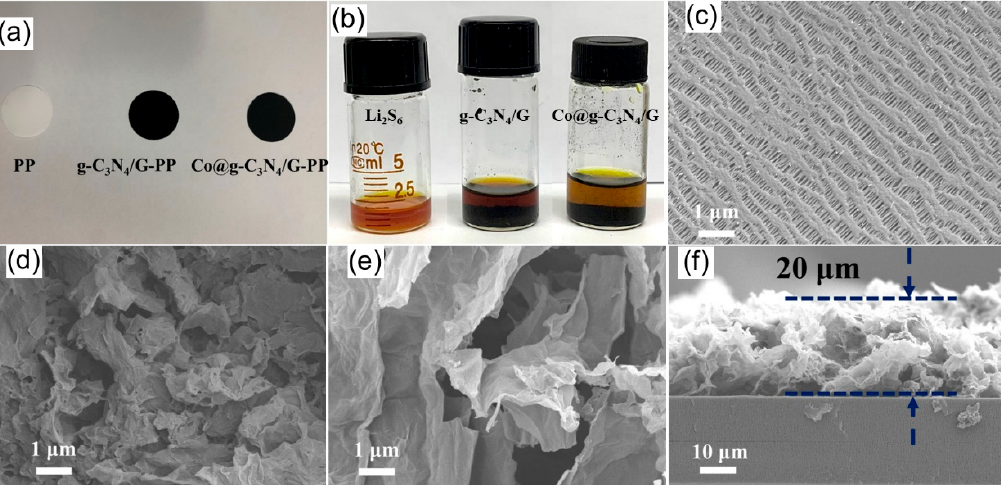
Figure 4. ( a ) Photographs of Li 2 S 6 solution contacting with Co@g-C 3 N 4 /G and g-C 3 N 4 /G. ( b ) Photographs of PP, g-C 3 N 4 /G-PP, and Co@g-C 3 N 4 /G-PP separators. SEM images of ( c ) PP and ( d,e ) Co@g-C 3 N 4 /G-PP separators. ( f ) Cross-sectional SEM image of Co@g-C 3 N 4 /G-PP separators.